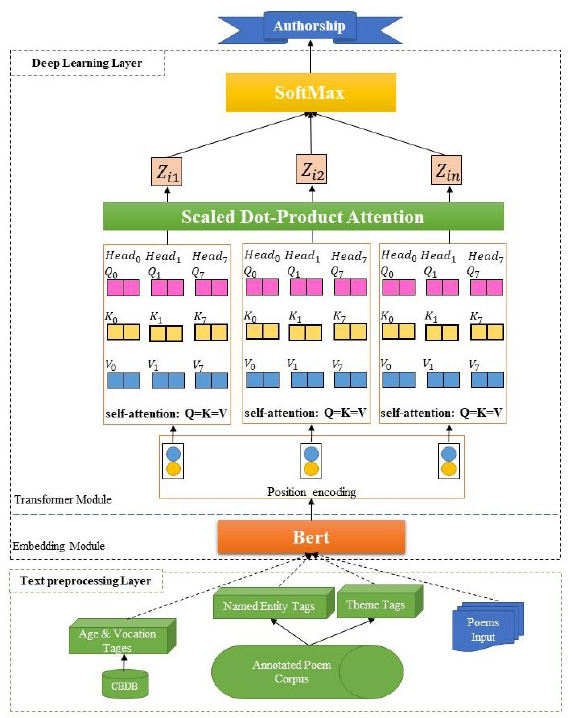
Figure 10. An illustration of our transformer model.